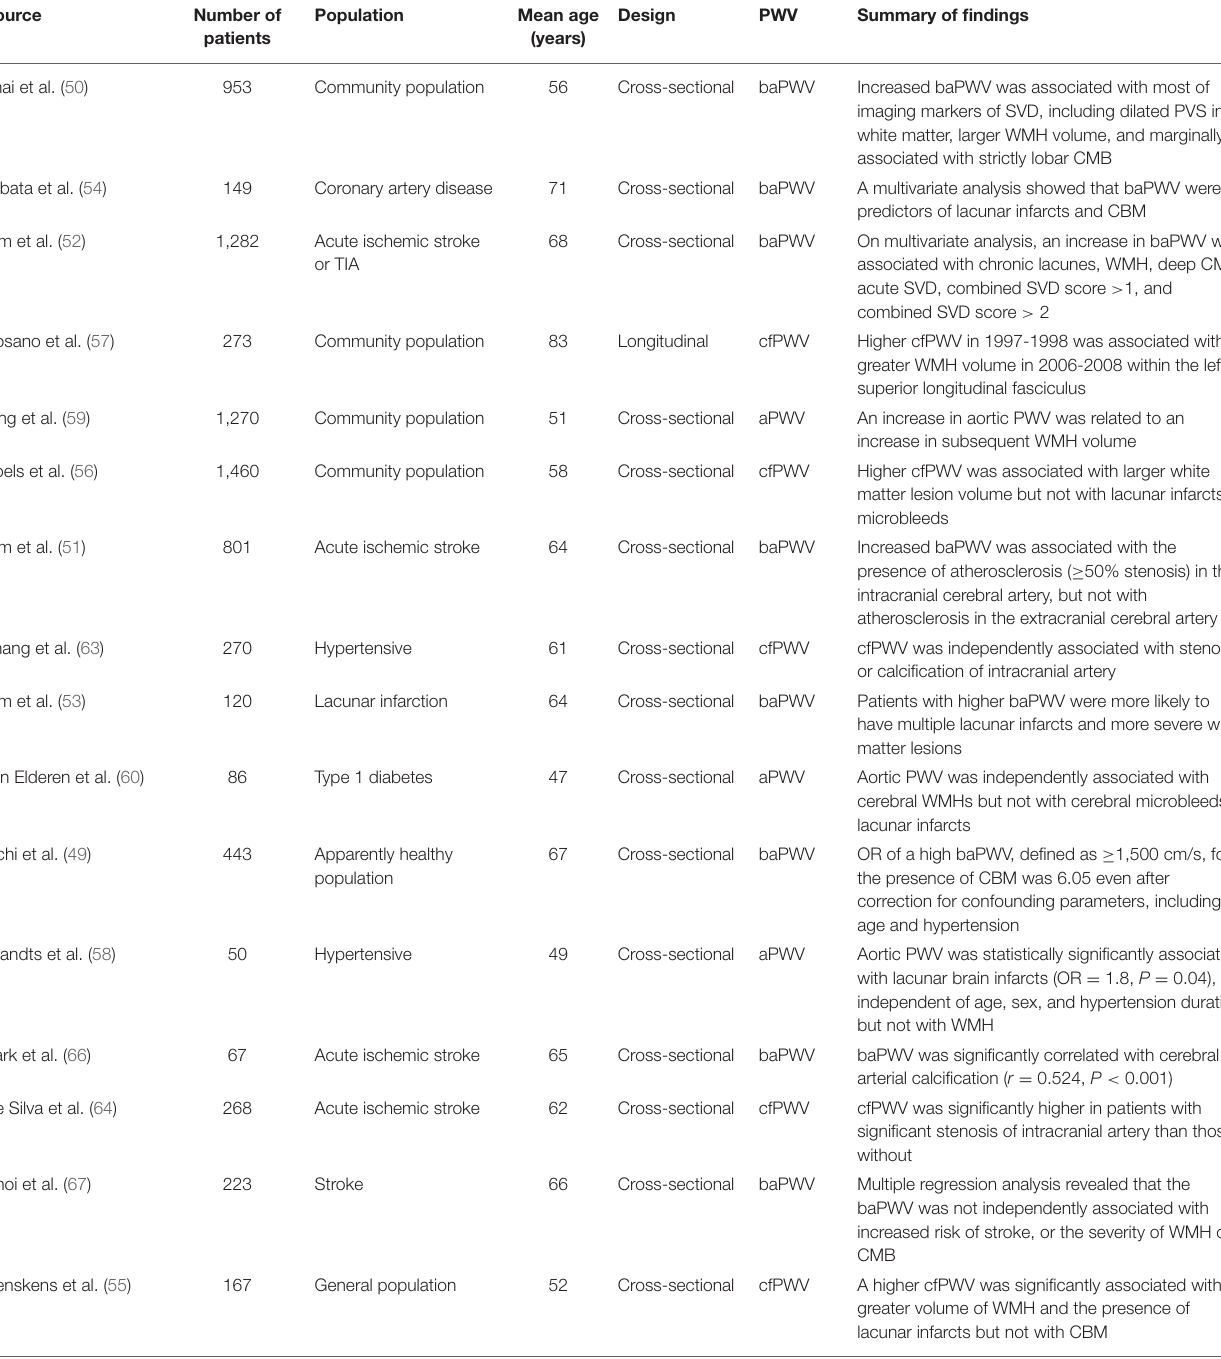
TABLE 2 | Summary of recent studies showing the association between pulse wave velocity and cerebral artery atherosclerosis.